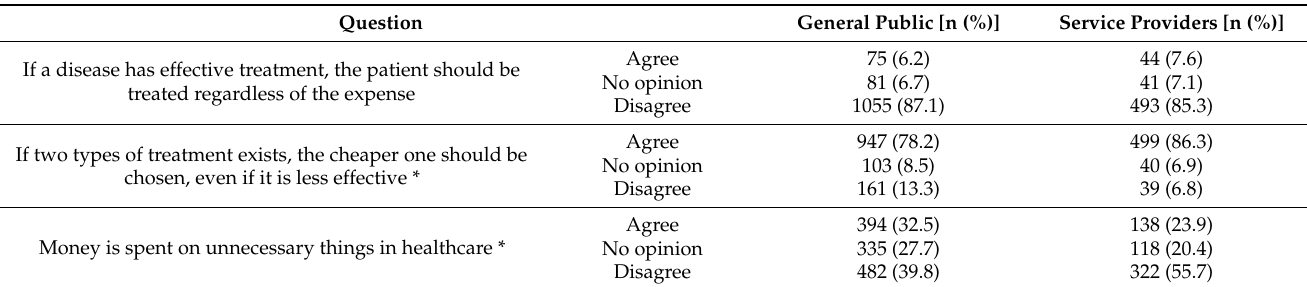
Table 8. Responses to statements on healthcare costs in Kuwait.